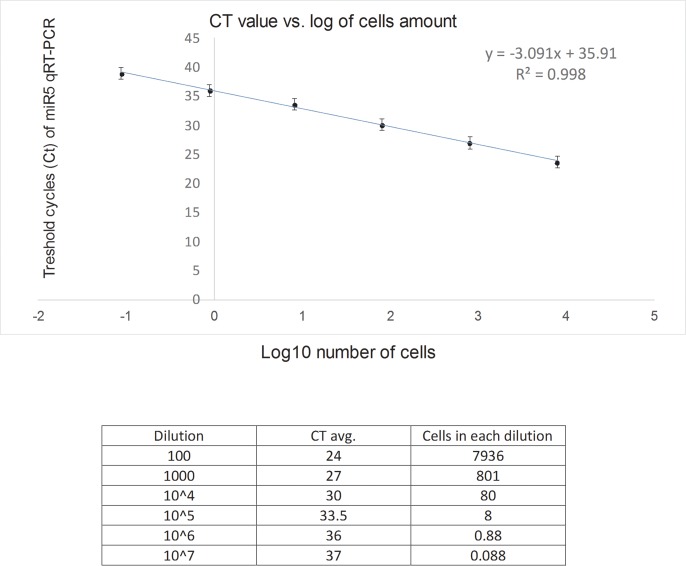
In-vitro calculation of miR5 qRT-PCR Ct value according to number of parasites.WB strain Giardia were grown in culture. Number of parasites were counted, and diluted as shown in the table. From each dilution, RNA was extracted and subject to qRT-PCR. The graph represents an average of three repeat, and as the log of parasites concentration versus obtained Ct.